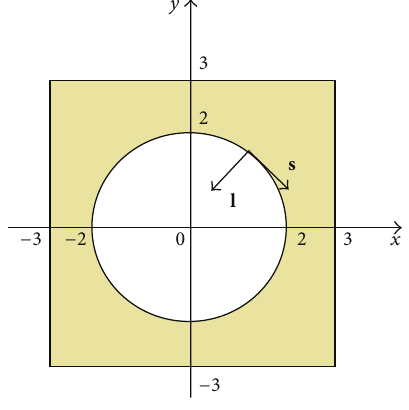
Figure 4: The considered domain Ω 1 .